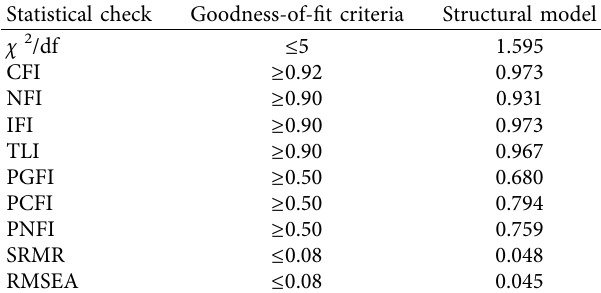
Table 3: Goodness-of-fit of the structural